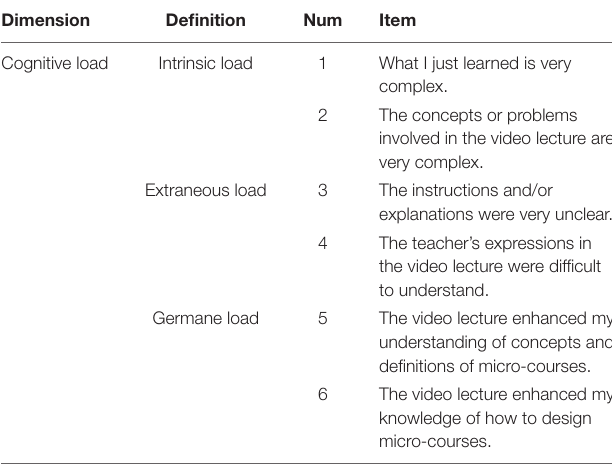
TABLE 2 | The six-item questionnaire for the measurement of cognitive load.